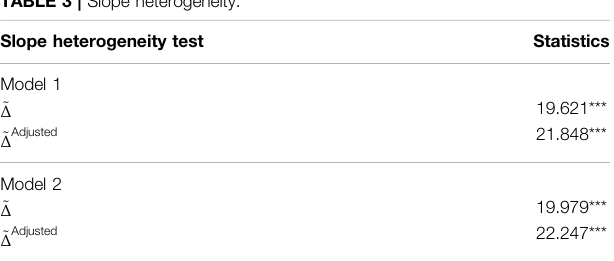
TABLE 6 | Cointegration